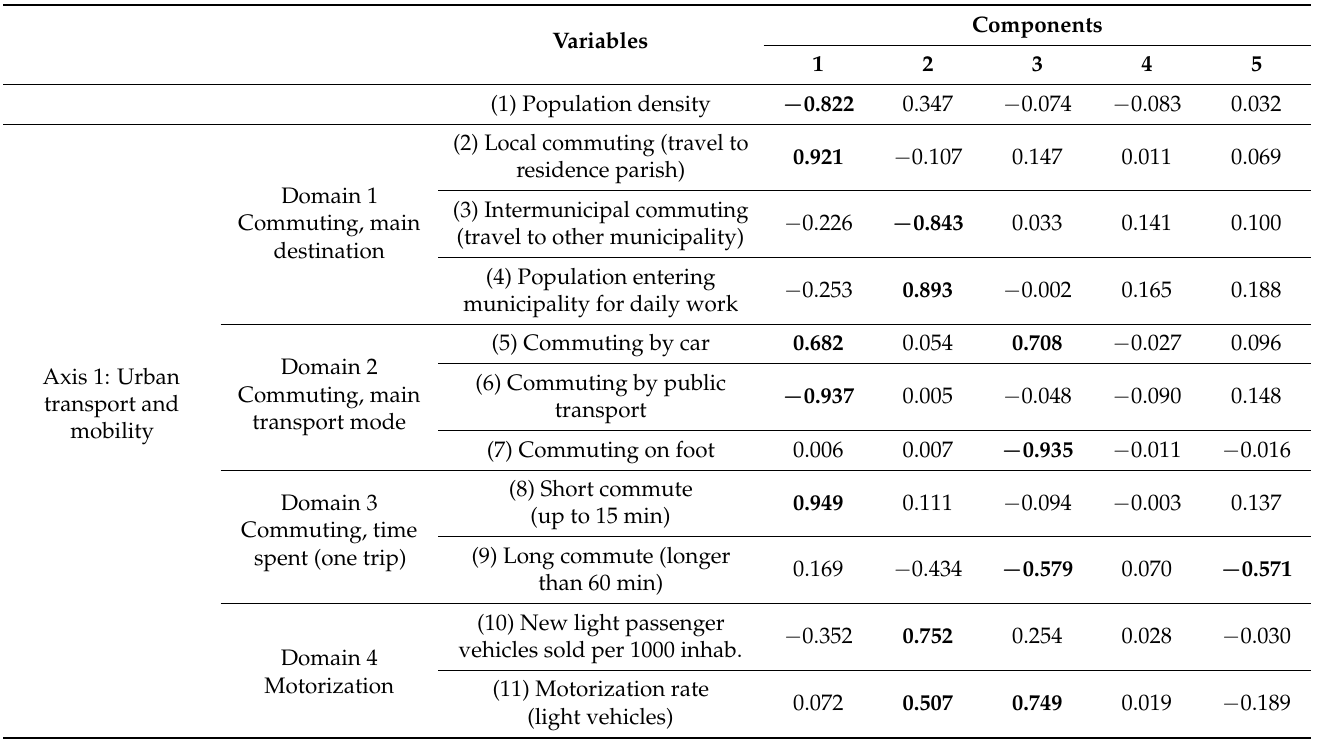
Table 3. Loadings and component